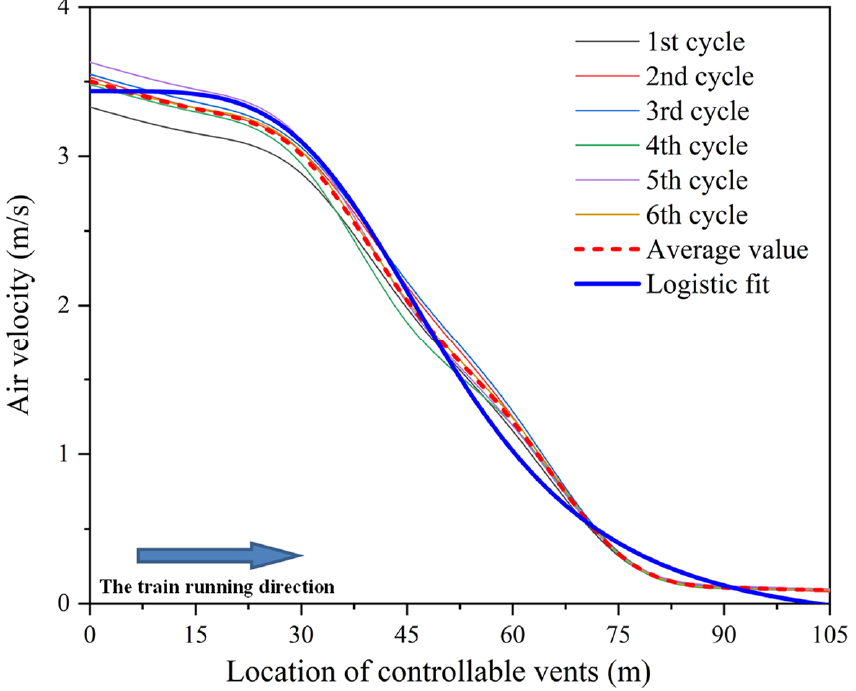
Figure 5. Air velocity distributions along the